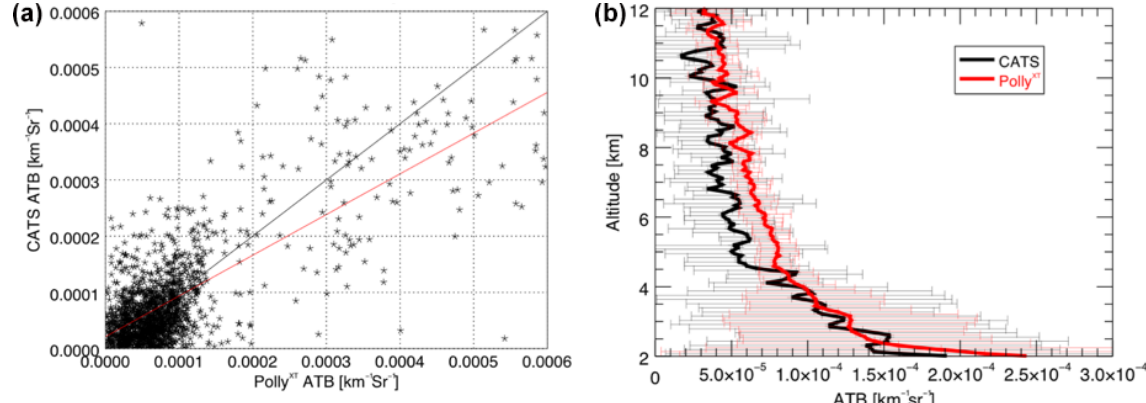
Figure 9. Scatter plot of all eight Polly XT –CATS comparison overflights (a) . The black line is the one-to-one line while the red line is the line fit of the data set. The correlation coefficient is 0.75. The average ATB profile from all eight Polly XT –CATS comparison cases (b) shows the CATS mean profile is on average 19.67% lower than Polly XT from 3 to 12km. The horizontal lines show the standard deviations of the mean profile for both CATS and Polly XT .